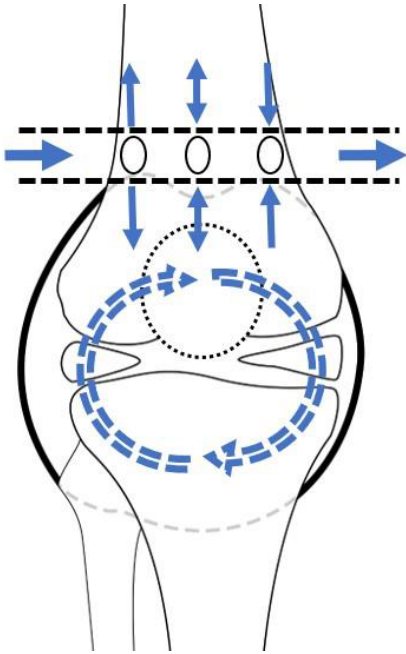
Figure 1. Schematic diagram of lavage by tube. The arrows depict the saline flow.